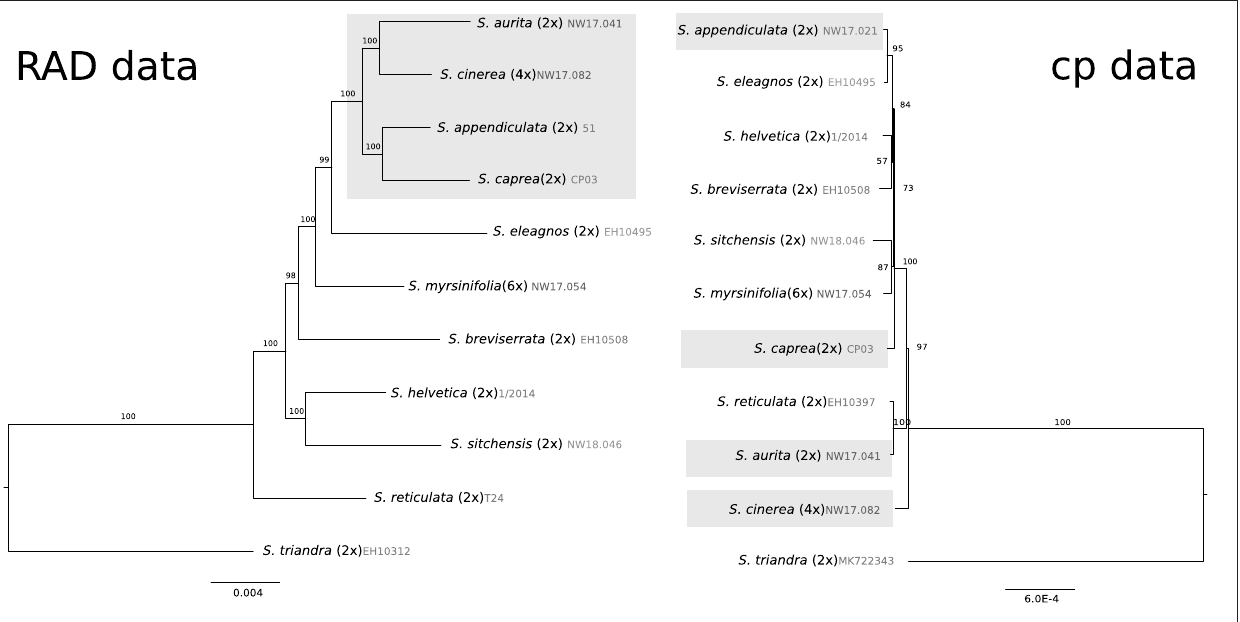
FIGURE 3 | Comparison of Maximum Likelihood phylogenies of a subset of 10 species of the Chamaetia/Vetrix clade with S. triandra as out-group based on 57,084RAD sequencing loci (left) and whole plastome data (right) . RAD sequencing data from Wagner et al. (2018, 2020). Bootstrap support values are given above branches. The ploidy level and accession numbers are indicated behind species names, the members of section Vetrix are highlighted in